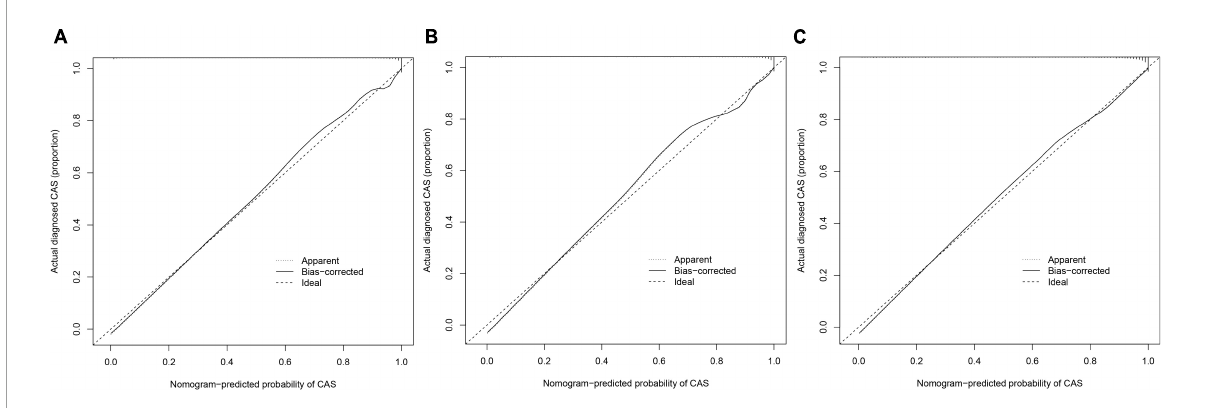
FIGURE6 Calibration curves. The x -axis represents the predicted CAS risk. The y -axis represents the actual diagnosed CAS. The diagonal dotted line represents a perfect prediction by an ideal model. The solid line represents the performance of the nomogram, of which a closer fit to the diagonal dotted line represents a better prediction. (A) Training set; (B) internal validation set; (C) external validation set.